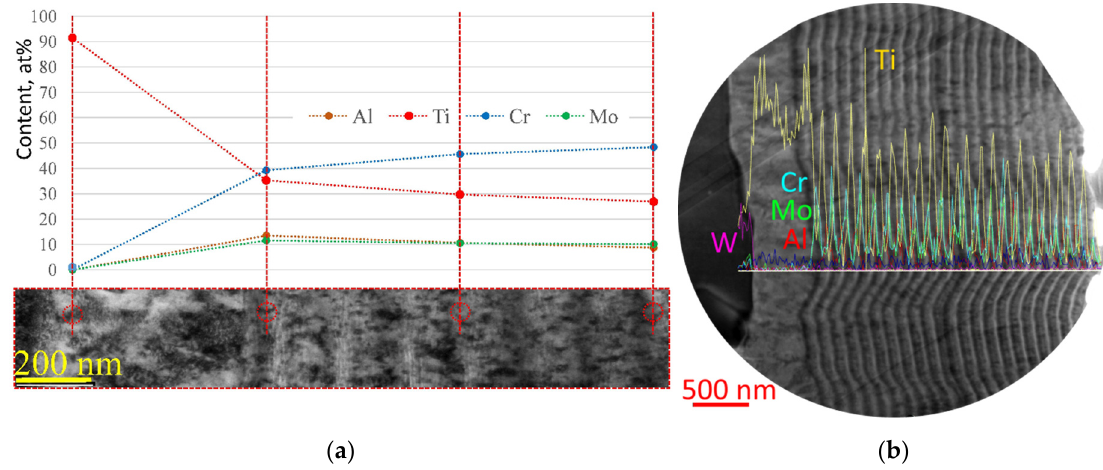
Figure 3. Distribution of chemical elements over the thickness ( a ) and change in the content of different elements in nanolayers ( b ) of coating Ti-TiN-(Ti,Cr,Mo,Al)N. Ti—22 at.%, Cr—38 at.%, Al—11 at.%, Mo—10